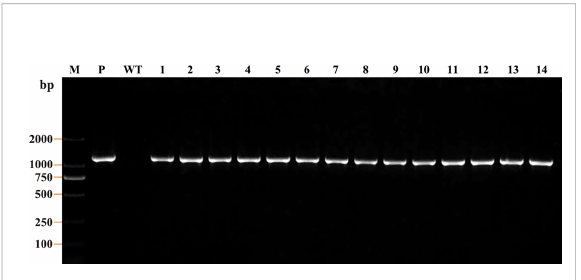
FIGURE 7 PCR analysis of the GUS-positive resistant callus of P. lacti fl ora . PCR product in 1182 bp was observed in each positive callus except wild-type with GUS gene-speci fi c primer. Lane M,